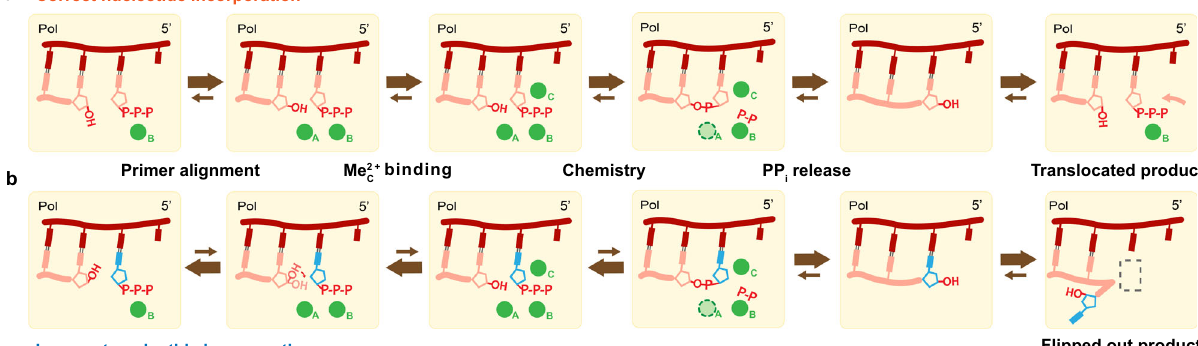
Fig. 6 Kinetic model of DNA polymerase catalysis. Proposed kinetic model during DNA polymerase correct nucleotide incorporation ( a ) and misincorporation ( b ). During correct nucleotide incorporation, the primer 3 ′ -OH is well-aligned by the Me 2 + A , and the reaction proceeds right after Me 2 + C binding. In contrast, during incorrect nucleotide incorporation, due to reduced base-stacking, primer 3 ′ -OH alignment is unfavored, which would lead to incorrect dNTP dissociation. Error-prone Mn 2 + A can drive 3 ′ -OH alignment and once the Me 2 + C binds, catalysis